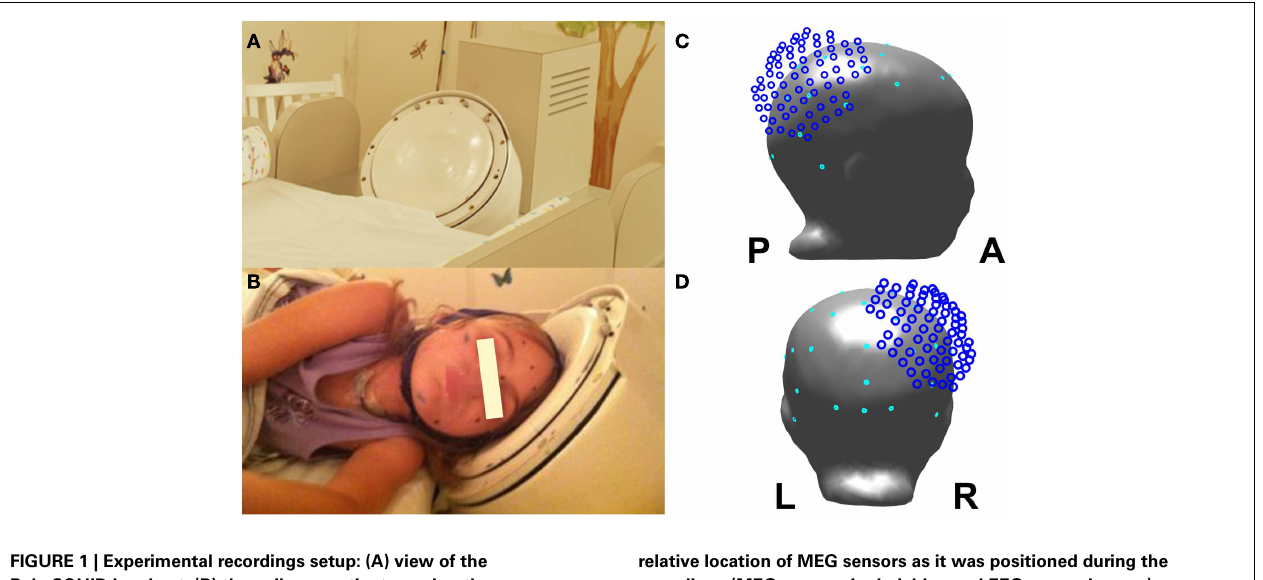
FIGURE 1 | Experimental recordings setup: (A) view of the BabySQUID headrest; (B) the epilepsy patient wearing the pediatric EEG cap and placing her head next to the BabySQUID headrest; (C) lateral view of patient’s head model with the